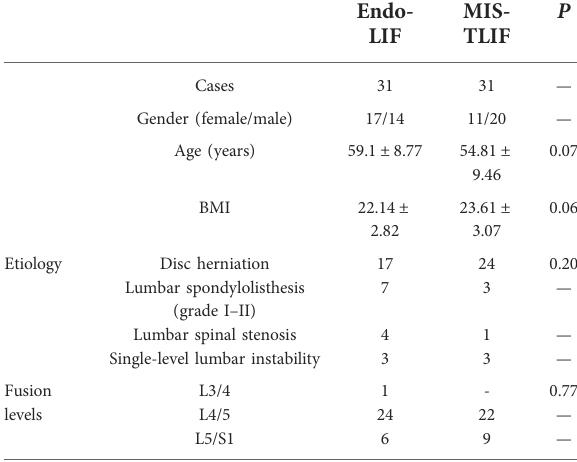
TABLE 1 Demographic data for the patients in the two